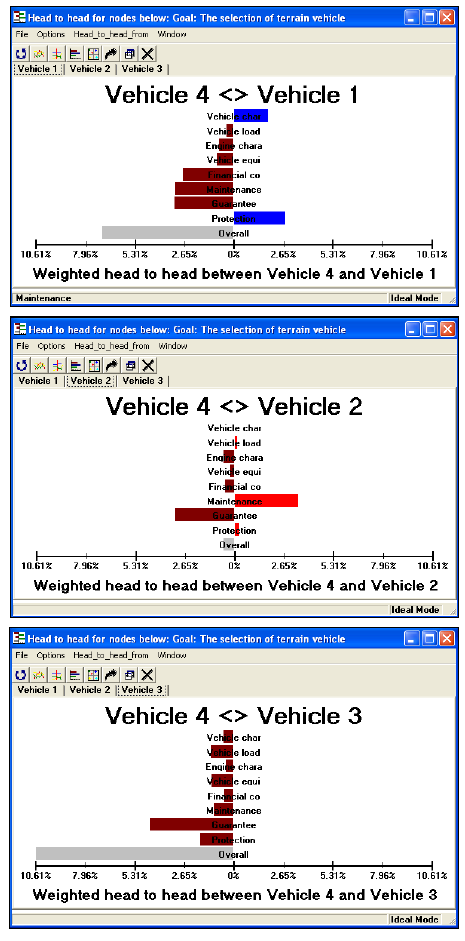
Figure 19. Head-to-head